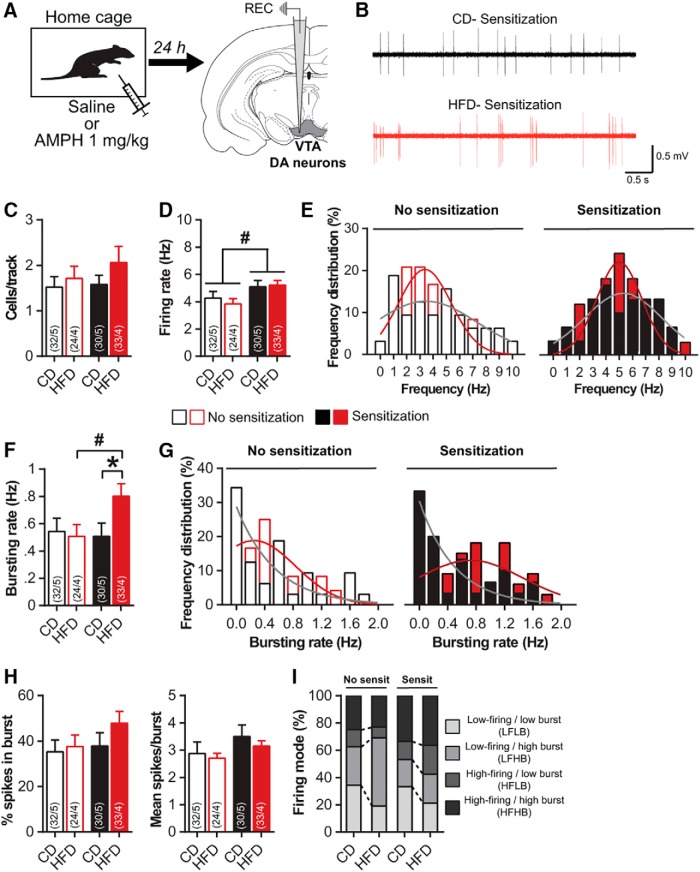
Amphetamine sensitization increases bursting activity of VTA-DA neurons after pHFD. A, Experimental schematic: 24 h after saline or amphetamine injection, VTA-DA neurons were recorded on anesthetized rats (no sensitization: CD n = 5 and pHFD n = 4; sensitization CD n = 5 and pHFD n = 4). B, Representative traces of VTA putative DA neurons for CD (top) and pHFD (bottom) groups 24 h after amphetamine injection. C, Number of spontaneously active DA neurons in the VTA is not affected by pHFD or amphetamine sensitization. D, Firing rate of VTA-DA neurons was not affected by pHFD but was increased by amphetamine sensitization. E, Distribution of VTA-DA neurons firing rate was not affected by pHFD (Kolmogorov-Smirnov test; no sensitization: D(56) = 0.19, p = 0.6; sensitization: D(63) = 0.18, p = 0.7) but was right-shifted by amphetamine sensitization (CD: D(62) = 0.21, p = 0.4; HFD: D(57) = 0.36, p = 0.05). F, Amphetamine sensitization increased the bursting rate of VTA-DA neurons only in pHFD rats. G, Distribution of VTA-DA neurons bursting rate was shifted toward high frequency in pHFD sensitized animals (Kolmogorov-Smirnov test; no sensitization: D(56) = 0.17, p = 0.8; sensitization: D(63) = 0.35, p < 0.05; CD: D(62) = 0.18, p = 0.6; HFD: D(57) = 0.34, p = 0.07). H, %SIB and burst size were not changed by pHFD or amphetamine sensitization. I, Firing modes patterns are not affected by pHFD. Numbers in bars indicate the number of cells and rats. Solid lines in E, G represent the best-fit distribution curve for the histogram data. Data are expressed as mean + SEM. *p < 0.05 diet effect; #p < 0.05 sensitization effect.